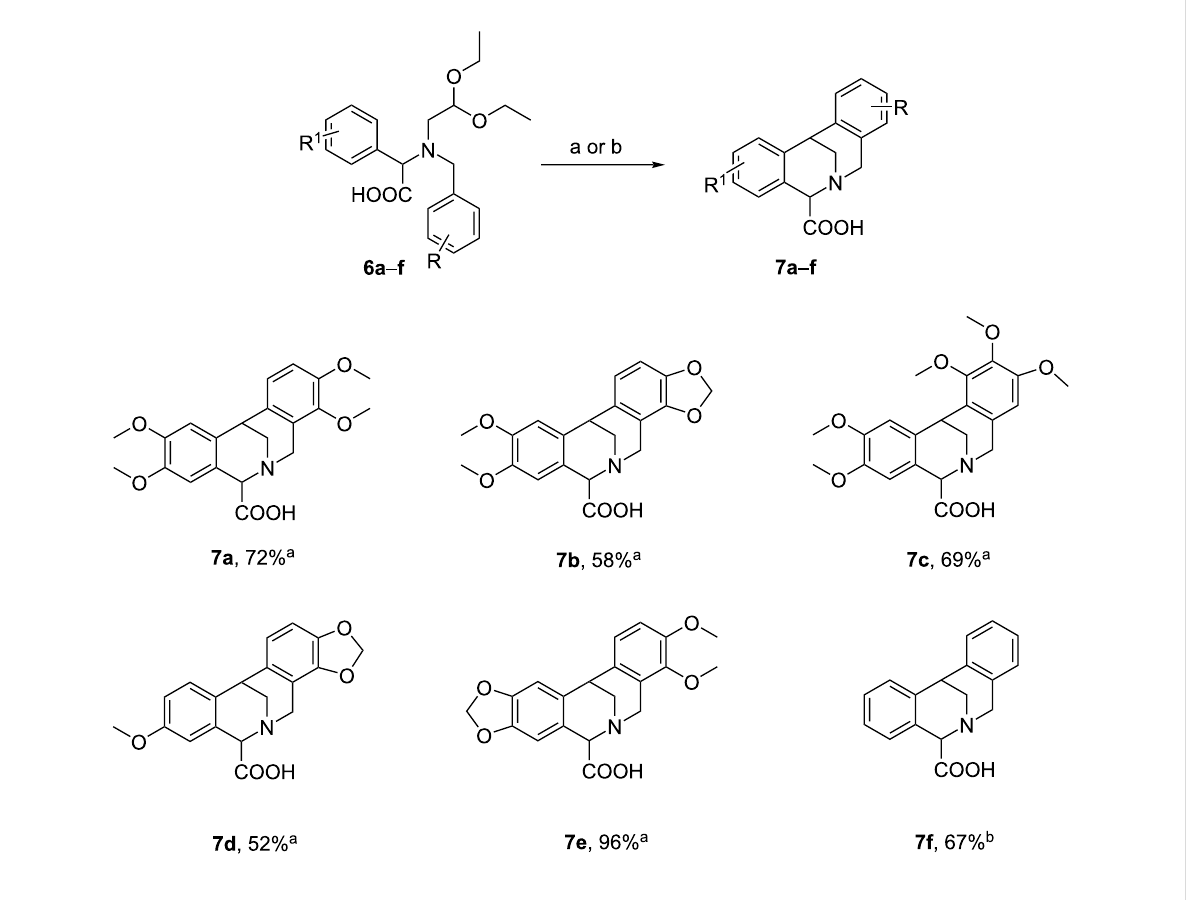
Scheme 5: Synthesis of dihydromethanodibenzoazocine-5-carboxylic acids 7a – f . Conditions: a) 20% HCl, rt, 24 h; b) 70% HClO 4 , rt, 12 h.